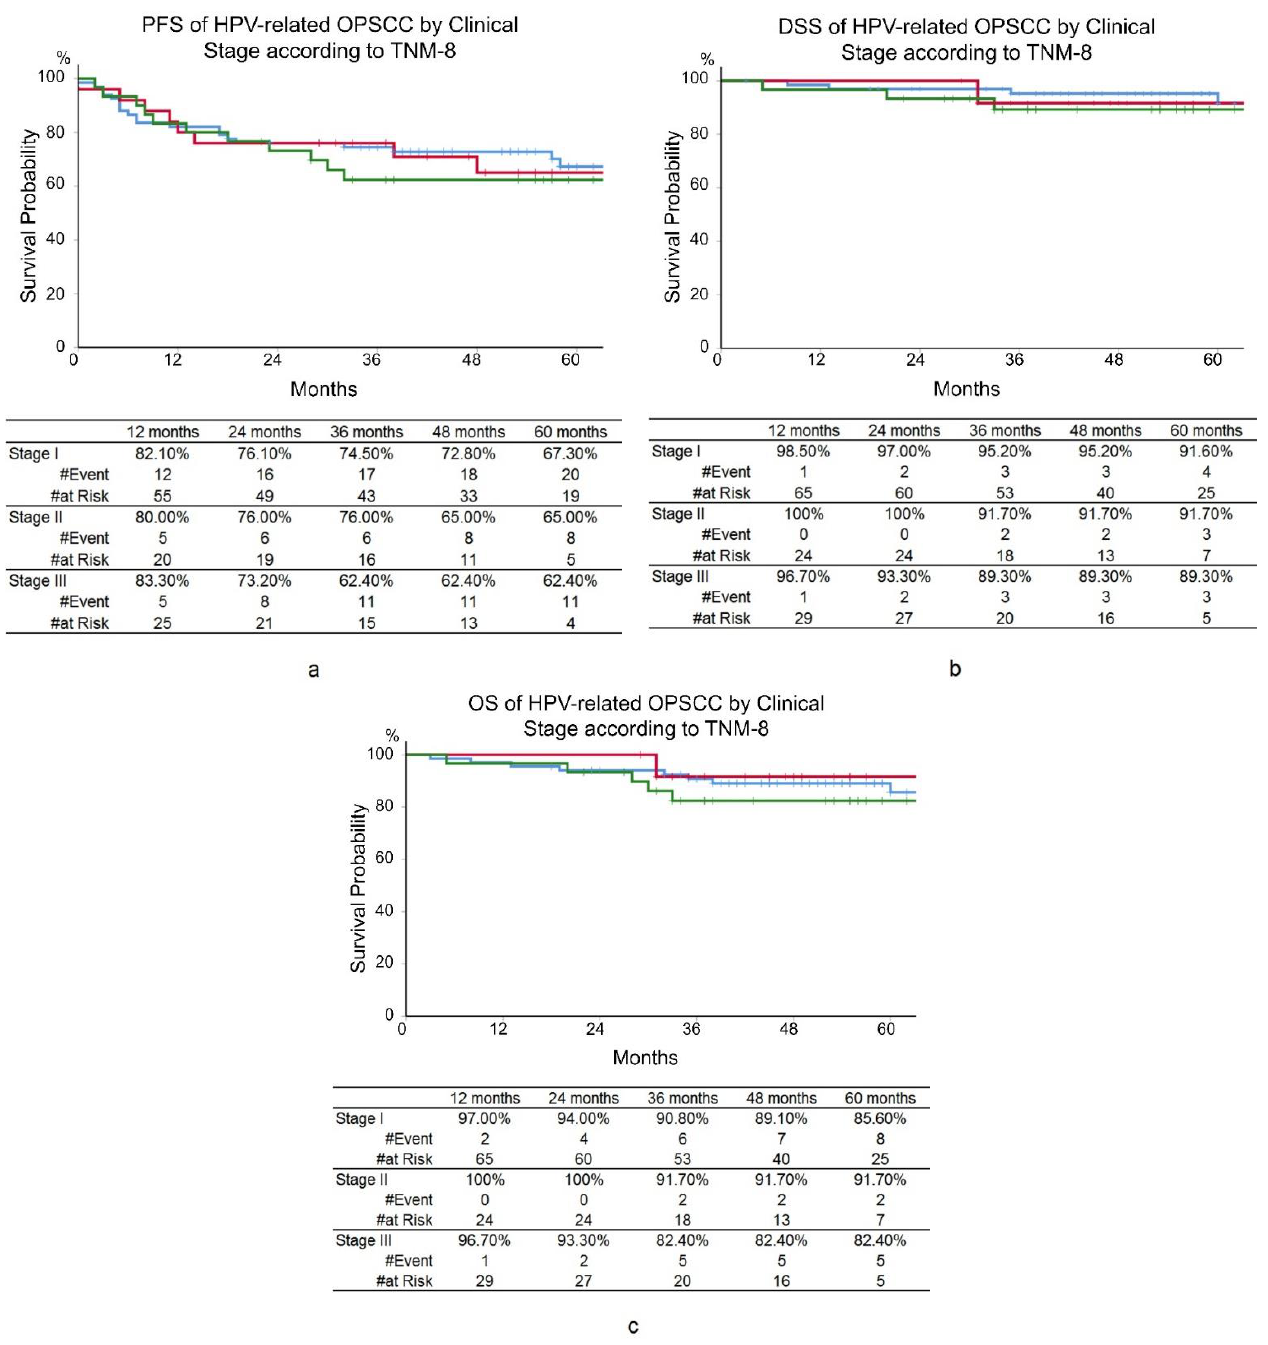
Figure 2. Kaplan–Meier curves. ( a ) Progression-free survival (PFS). ( b ) Disease-specific survival (DSS). ( c ) Overall survival (OS) of human papillomavirus-related oropharyngeal squamous cell carcinoma (HPV-related OPSCC) according to the clinical stage by TNM 8th edition. Blue lines: stage I, red lines: stage II, green lines: stage III. No significant differences were seen in prognoses between clinical stages according to TNM-8.